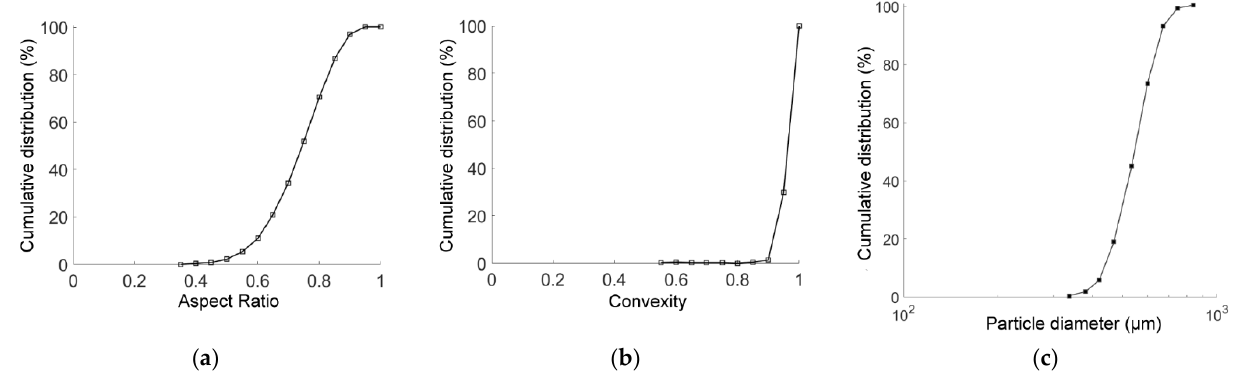
Figure 1. Cumulative distribution curves for ( a ) aspect ratio, ( b ) convexity and ( c ) grading of Fujian sand [39].